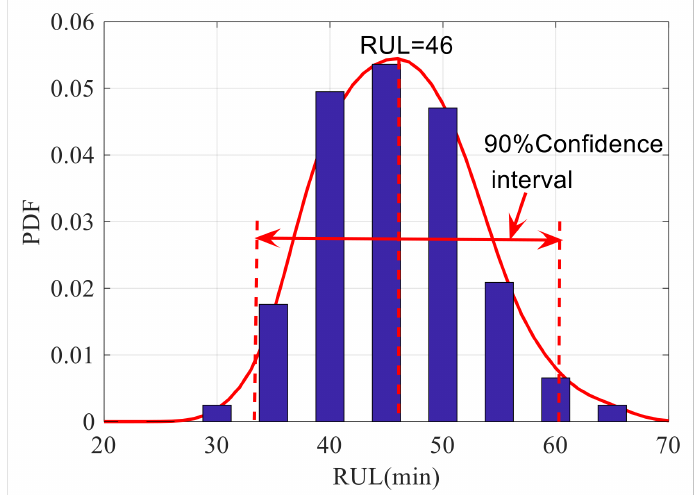
Figure 14. The histogram and PDF of the 100 predicted RUL values. As shown in Figure 14, according to the statistical results, the RUL has the largest value of the PDF in 46. Hence, the RUL estimate from Monte Carlo simulation is 46. Since the sampling interval is minutes, all RUL values in this work are given in minutes. Then, the PDF of the RUL at 10 different prediction starting points of the operation process is obtained by Monte Carlo simulation. The prediction results of the PDFs by different models are shown in Figure 15